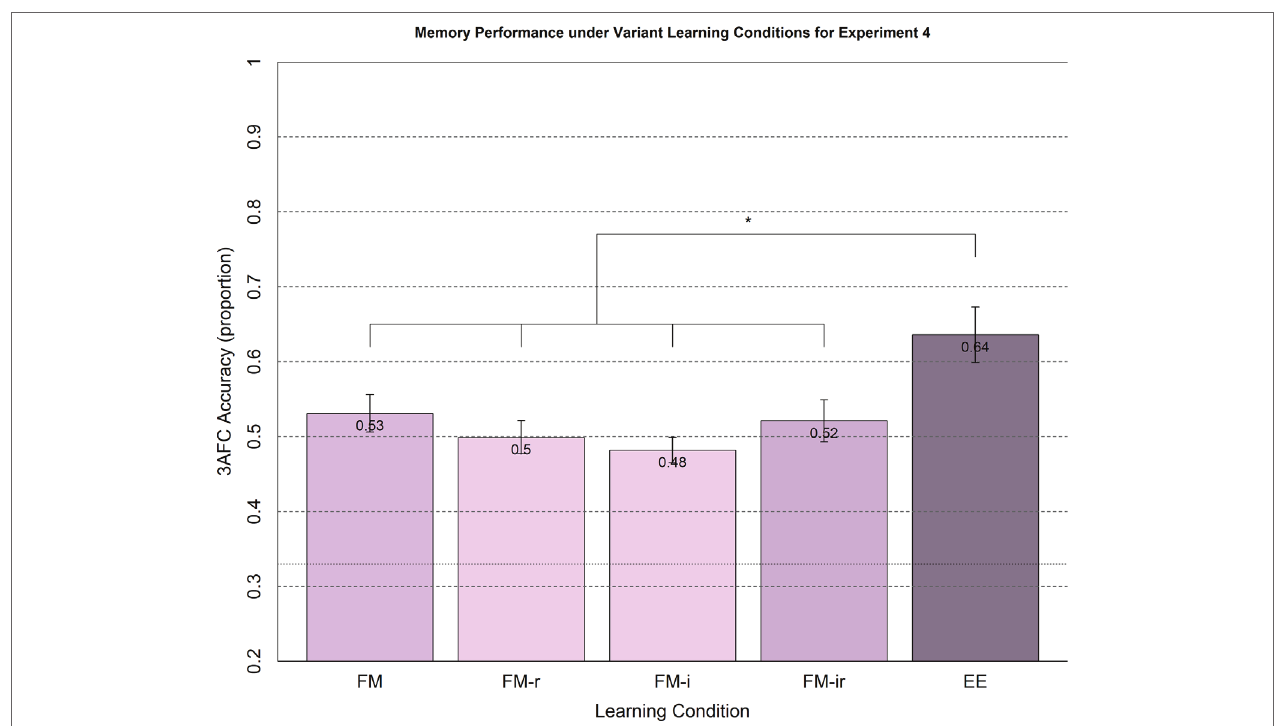
FIGURE 4 | Memory performance in Experiment 4 from 3AFC at the test phase (chance = 0.33) for FM variants and EE. Conditions were administered between- participant. Memory performance for healthy young adults under FM, FM-r, FM-i, and FM-ir did not significantly differ between conditions. All FM conditions significantly differed from the explicit learning condition, EE. Significant differences are marked * = p < 0.05, two tailed. Mean performance is reported at the top of each bar. Error bars are standard error of the